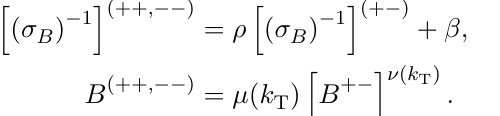
Figure 2 . Relations between same-sign (++ ; (cid:0)(cid:0) ) and opposite-sign (+ (cid:0) ) (cid:12)t parameters from eq. (5.4), as a function of k and N o(cid:15)ine for events in MB (i.e., higher (cid:27) (cid:0) 1 and lower log B) and HM T trk B 10 (i.e., lower (cid:27) (cid:0) 1 and higher log B) ranges. The (cid:12)t values found for the parameters corresponding B 10 to the peak’s width (left) and the amplitude (right) of the same-sign and opposite-sign correlations are shown. For a given k range, each point represents an N o(cid:15)ine bin. The line in the left plot is T trk a linear (cid:12)t to all the data. The error bars represent statistical uncertainties. (++ and (cid:0)(cid:0) ) to those found for OS (+ (cid:0) ) MC